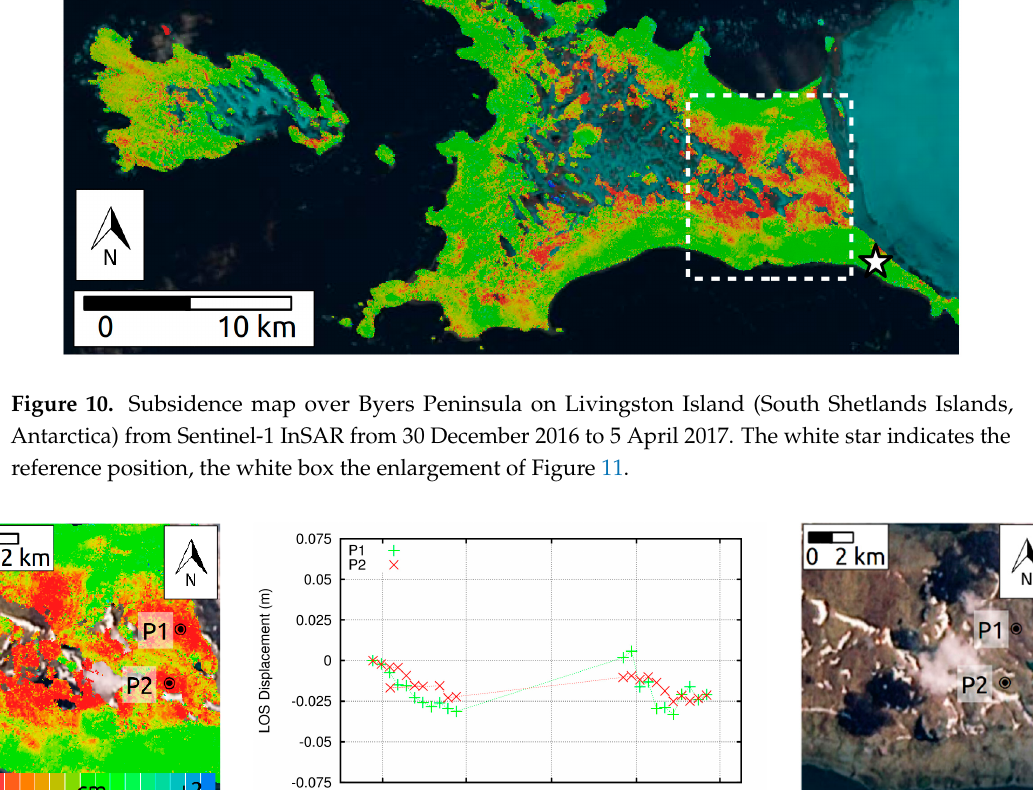
Figure 11. Time series of displacement in the line-of-sight direction over two points on the plateau surfaces of Byers Peninsula. For location see Figure 10. Map data are from Bing Aerial.